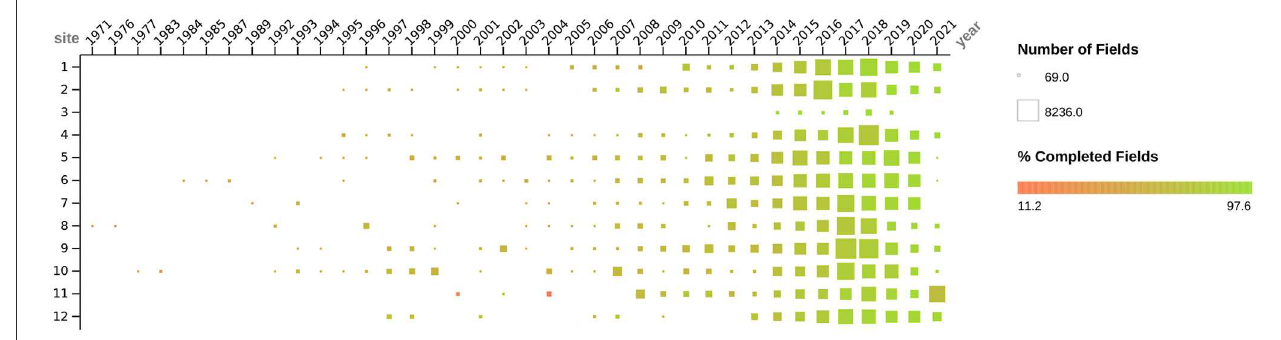
FIGURE2 Figure depicts the dates, quantity, and degree of completeness for all social determinants of health data (i.e., DS-1 and DS-2) collected as described above by study sites. Dates when forms were administered to participants range from 1971 to 2021. The quantity of data collected (i.e., number of fields) from each site is depicted by the size of the box, ranging from 69 to 8236 fields. The color of the box, ranging from red to green, depicts the degree of field completeness, ranging from 11.2 to 97.6%.